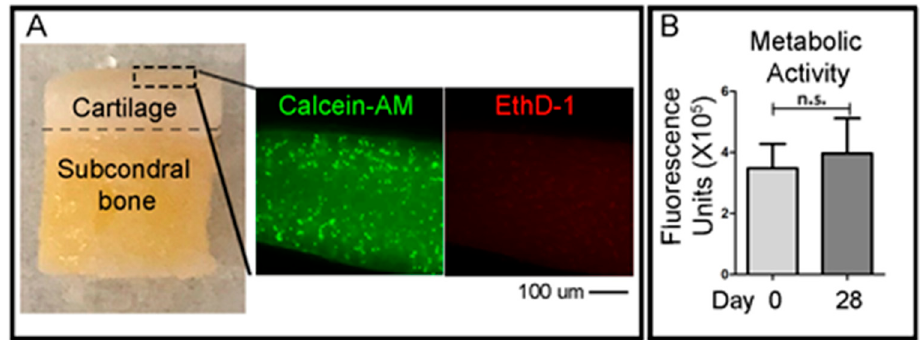
Figure 4. ( A ) Picture of an OC plug and representative epifluorescence images of LIVE/DEAD ® staining performed on cartilage slices (dotted line area in the OC plug picture). Calcein-AM (alive cells) is shown in green and Ethidium homodimer-1 (dead cells) is shown in red. Scale bar 100 um corresponds to 100 µ m. ( B ) The graph shows the metabolic activity measured with CellTiter-Blue assay and fluorescence reading at day 0 and 28 days under maintenance in the U-CUP CellecBiotek ® perfusion bioreactor. Error bars represent standard deviation between three biological replicates. No statistical significance was found with an unpaired t test between day 0 and day